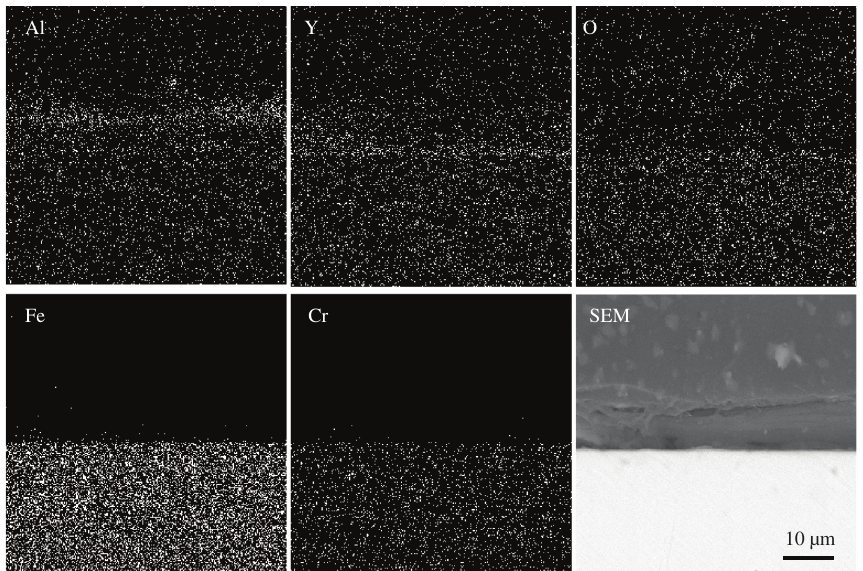
Figure 1: EDX pattern and cross- sectional morphology of the AlY